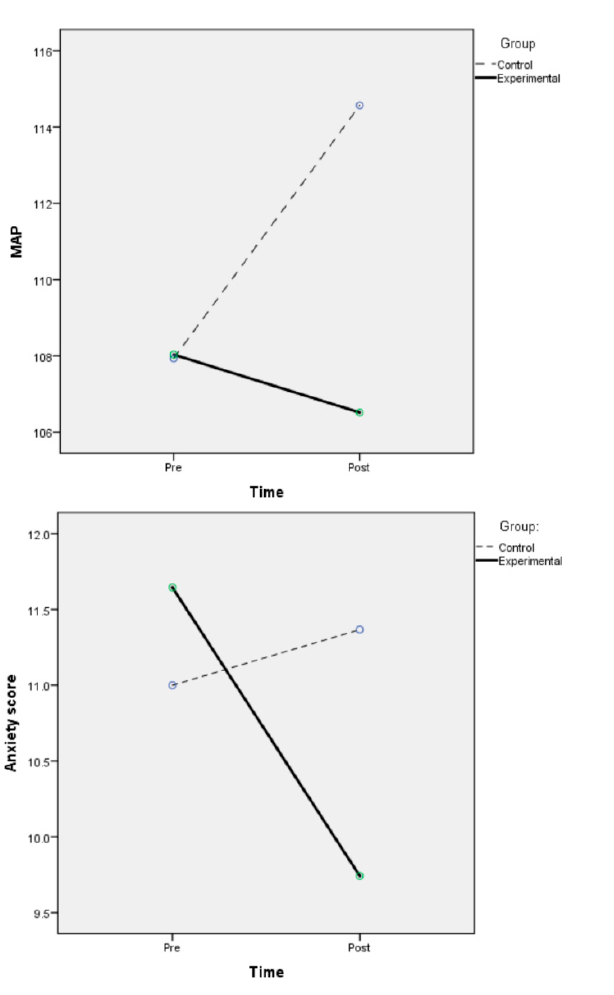
Figure 2. Mean values of outcomes variables for control and experimental groups at pre- and post-test.